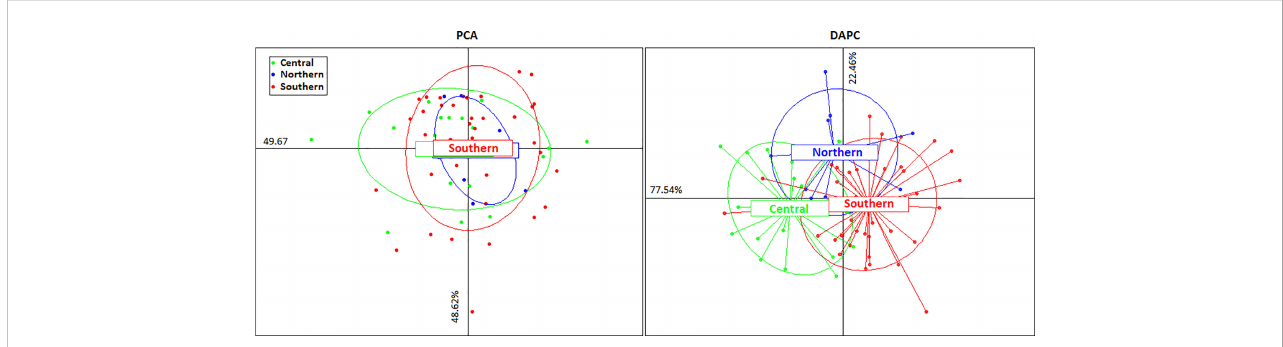
FIGURE 4 PCA and DAPC. Graphs obtained from 1,034 neutral SNPs. PCA graph points represent Bothus robinsi individuals (66) from the three regions sampled in the Gulf of Mexico; DAPC graph points represent different Bothus robinsi individuals (66), color pattern different sampling regions (blue=northern, green central, and red=southern).